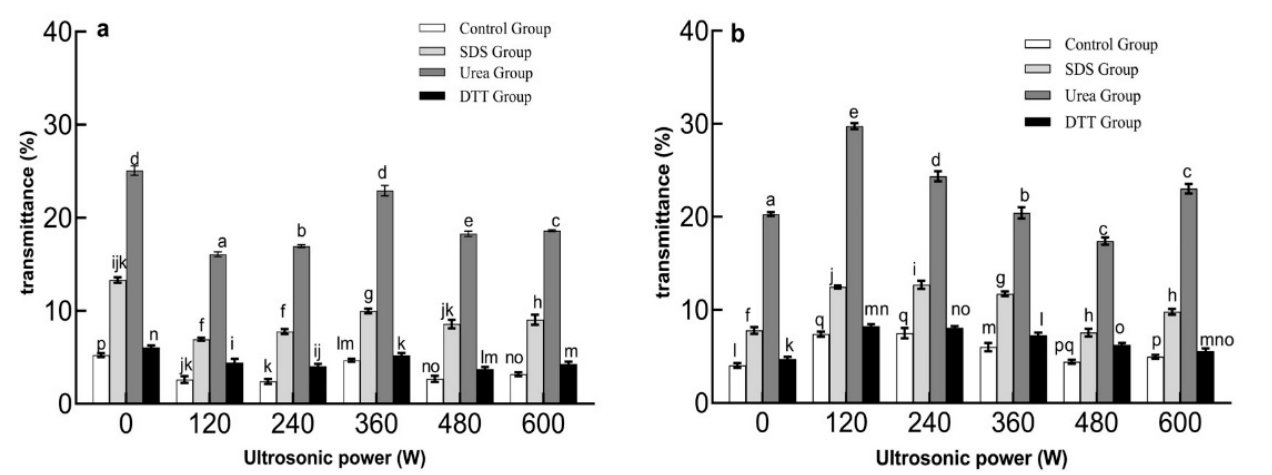
Figure 4. The transmittance of ultrasonic treatment EWP-GPs ( a ) and ultrasonic-TGase treatment EWP-GPs ( b ). (Values with different letters are significant at p < 0.05).